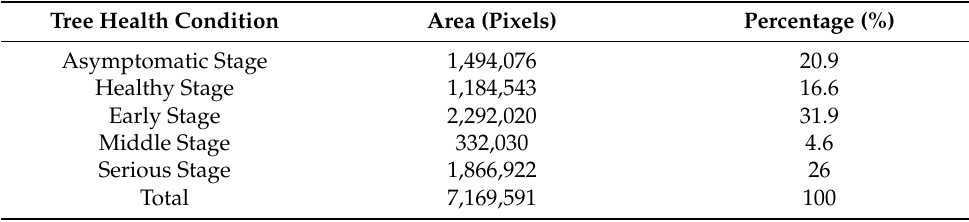
Figure 8. Spatial distribution of rubber trees infected with powdery mildew based on selected features (spectrum, texture, color) and SVM model. Table 8. Pixel area and percentage of infected areas in rubber trees.